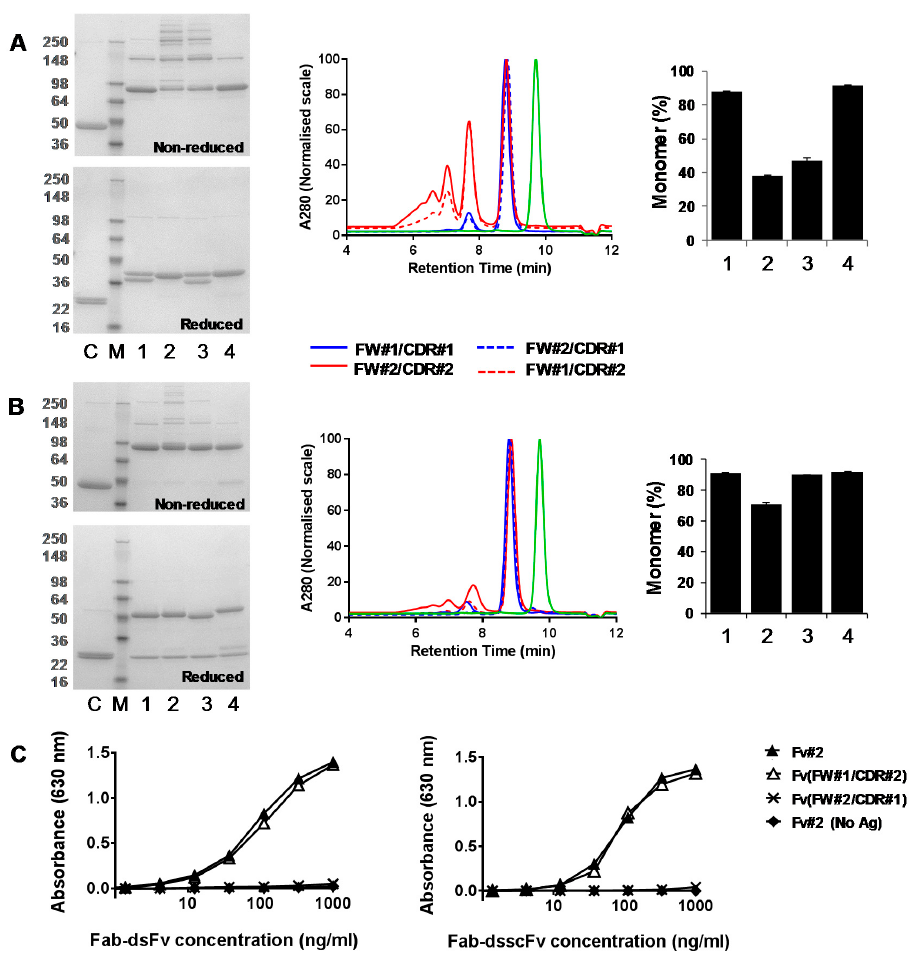
Figure 4. Comparison of Fab-dsFv and Fab-dsscFv with wildtype and FW/CDR-‘swapped’ Fv. SDS-PAGE and G3000 SEC analysis of proteins purified by Protein G HPLC from 293F cells— representative data from one of three independent experiments are shown. ( A ) LEFT—non-reducing and reducing SDS-PAGE gel of Fab-dsFv proteins. M—molecular weight marker; C – HER2 Fab